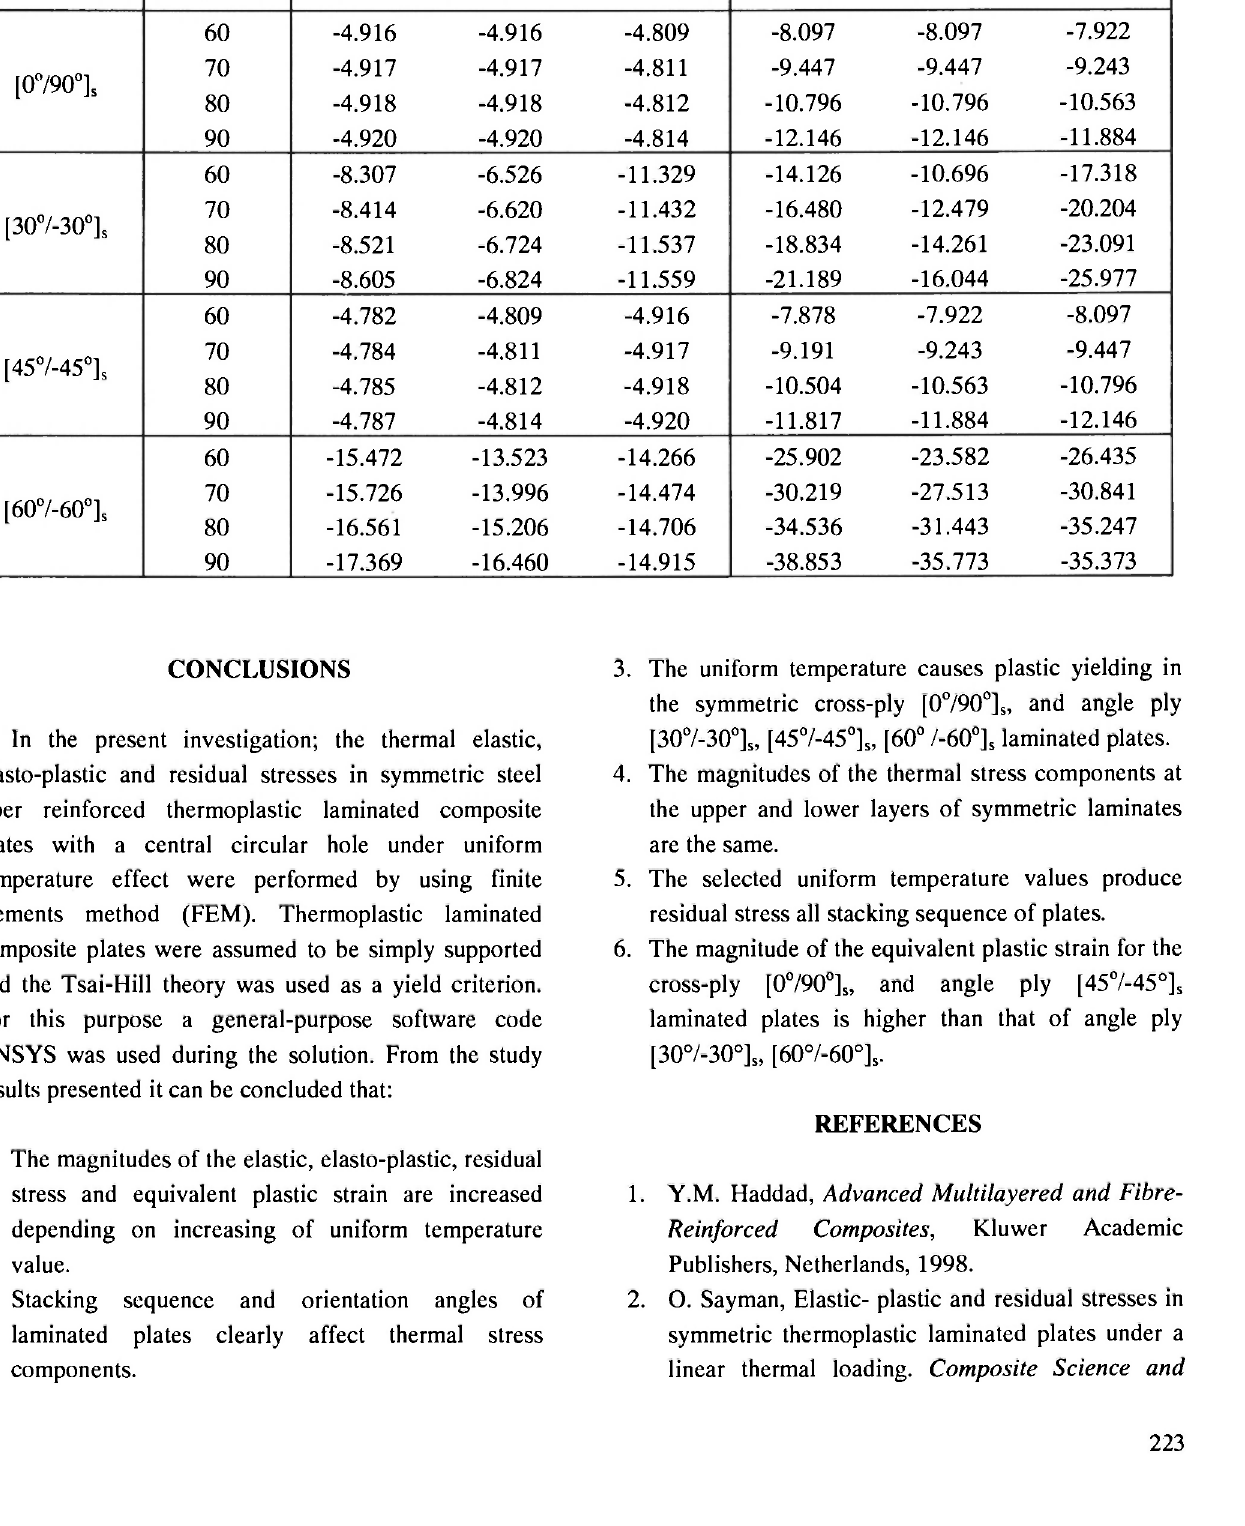
and angle/ply [ 3 0 s